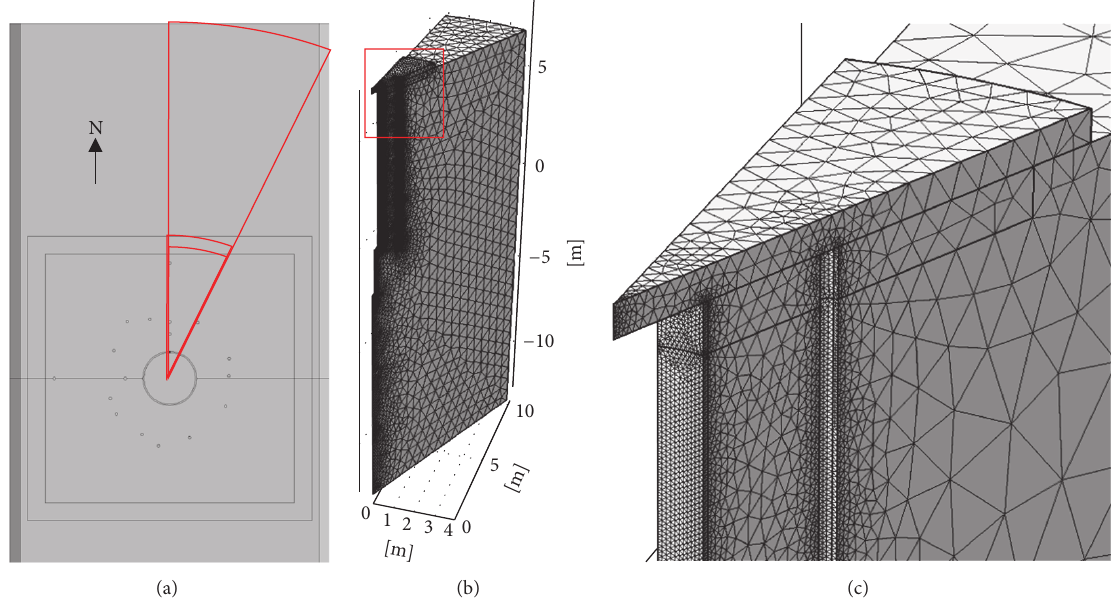
Figure 7: Location of the 1/16th slice taken and conversion of orthogonal components to cylinders (a), the whole modelling domain with mesh (b), and mesh detail showing the insulation, concrete foundation slab, liner, and half a heater hole (c).